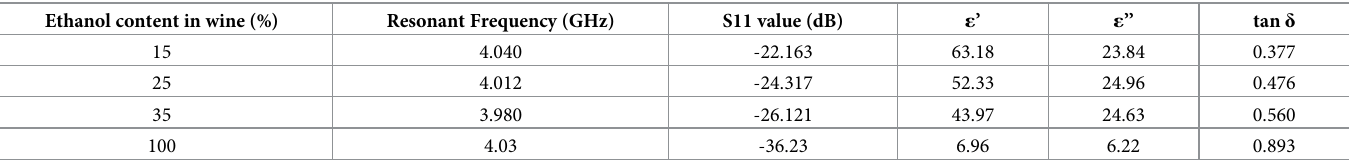
Table 3. Variations in resonant frequency, S 11 and dielectric parameters measured by the proposed antenna sensor with respect to different amounts of ethanol. Ethanol content in wine (%)